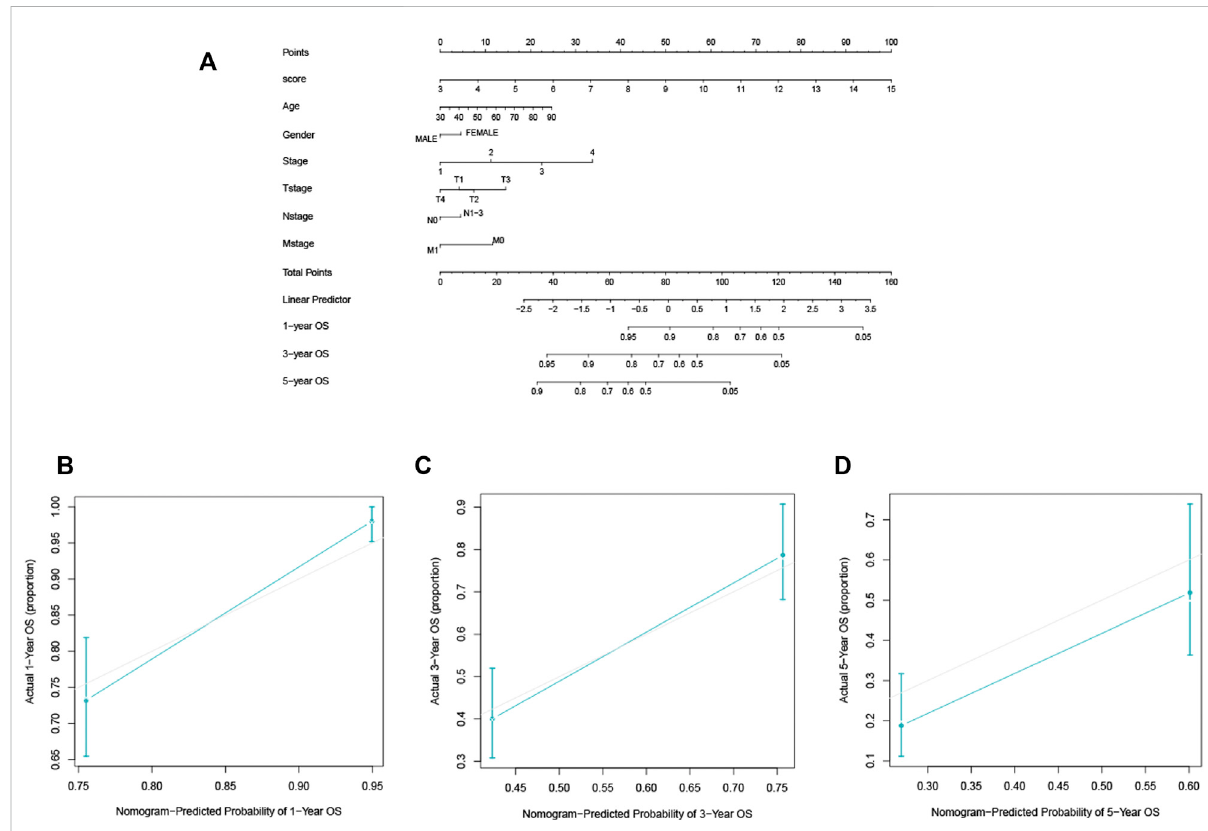
FIGURE 5 The construction and validation of the nomogram for OS. (A) The designed nomogram was used to assess OS. (B – D) The calibration curves demonstrated good congruence between the observed likelihood of 1-, 3-, and 5-year survival and the forecast of the nomogram.